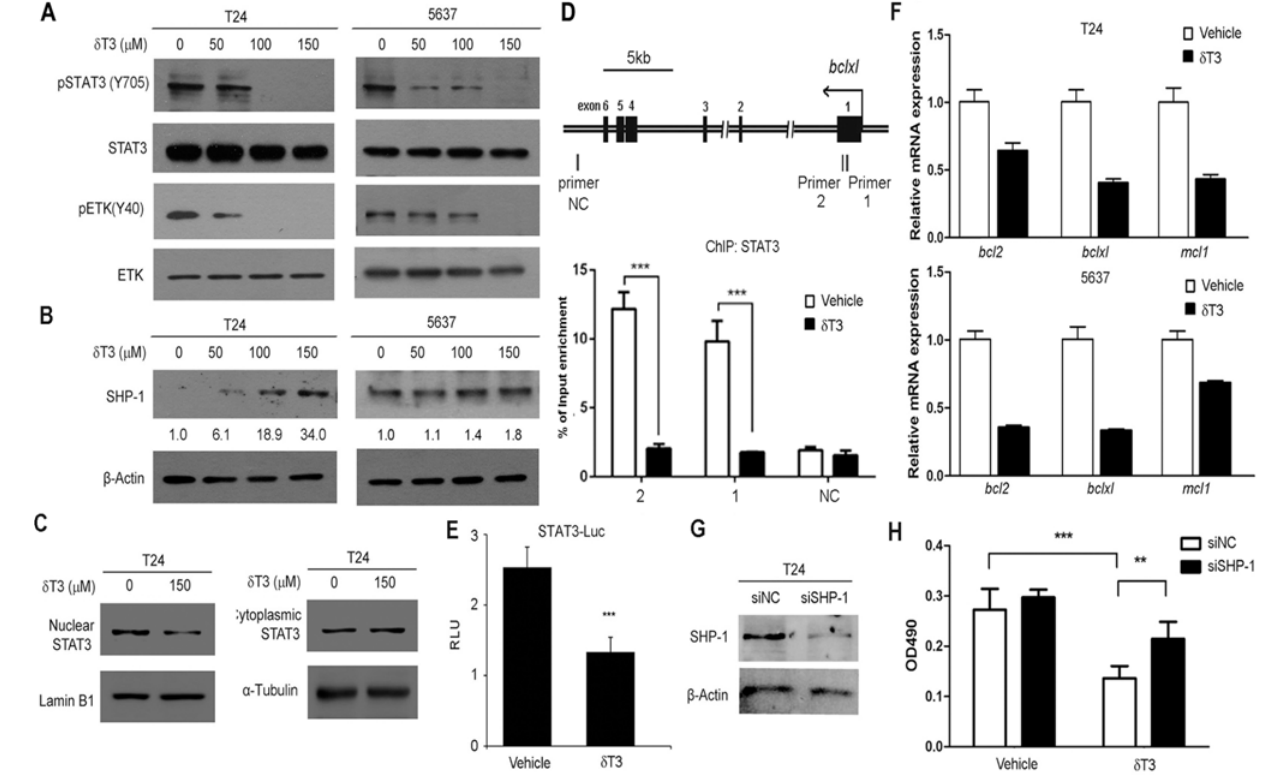
Fig 5. δ -T3 suppresses STAT3 signaling pathways in human bladder cancer cells. Western blotting analysis of the STAT3/ETK signaling pathway- related (A) and SHP-1 (B) protein levels in T24 and 5637 cells under the δ -T3 treatment for 24 h. Western bands were quantified by Image J software and the digits shown below the upper panel were the relative STAT3 expression levels normalized by loading controls. (C) Reduction of nuclear STAT3 protein level upon the treatment of 150 μ M δ -T3 in T24 cells. LaminB1 was used as a nuclear loading control. Tubulin was used as a cytoplasmic loading control. (D) Genomic structure of bclxl gene was shown, with the labels of three primer sets for ChIP assay. Primer set 1 and 2 contain STAT3 binding element; whereas primer set 3 (NC) serves as negative control. STAT3 occupancy in the bclxl promoter in bladder cancer cell line T24 treated with 150 μ M δ -T3 or vehicle for 18 h were assayed by ChIP assay. Input DNA and immunoprecipitated DNA were analyzed by qPCR analyses using primer sets depicted above and normalized by IgG control. The error bar indicates the means ± SD. *** , P < 0.001. (E) δ -T3 treatment reduced the STAT3 downstream target genes ( bcl2 , bclxl and mcl-1 ) expression at mRNA level. (F) Luciferase activity analysis of STAT3-Luc upon the treatment of 150 μ M δ -T3 in T24 cells for 24 h. TK-Renilla luciferase plasmid was used as internal control. (G) Knockdown efficiency of SHP-1 in T24 cells by Western blotting assay. β – Actin was used as